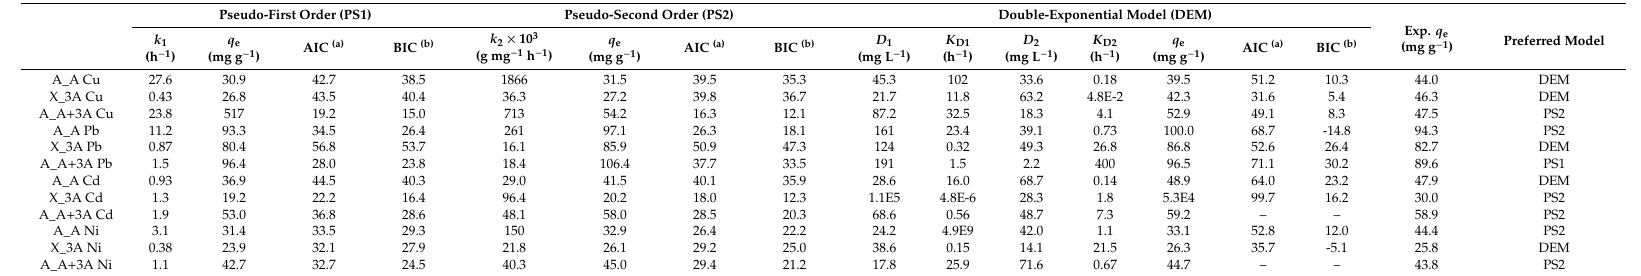
Table 5. Adsorption model and fit parameters for sorption